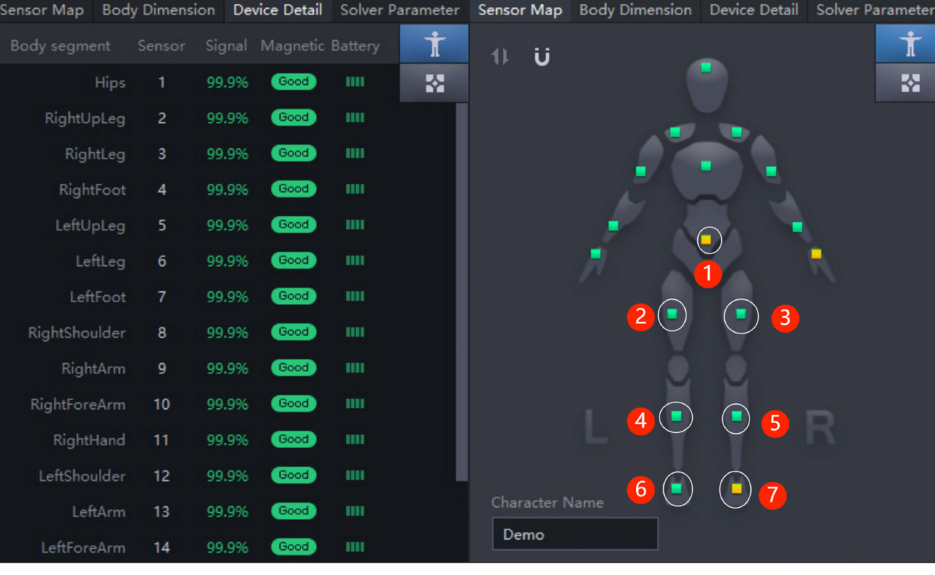
Figure 3. Equipment software operation